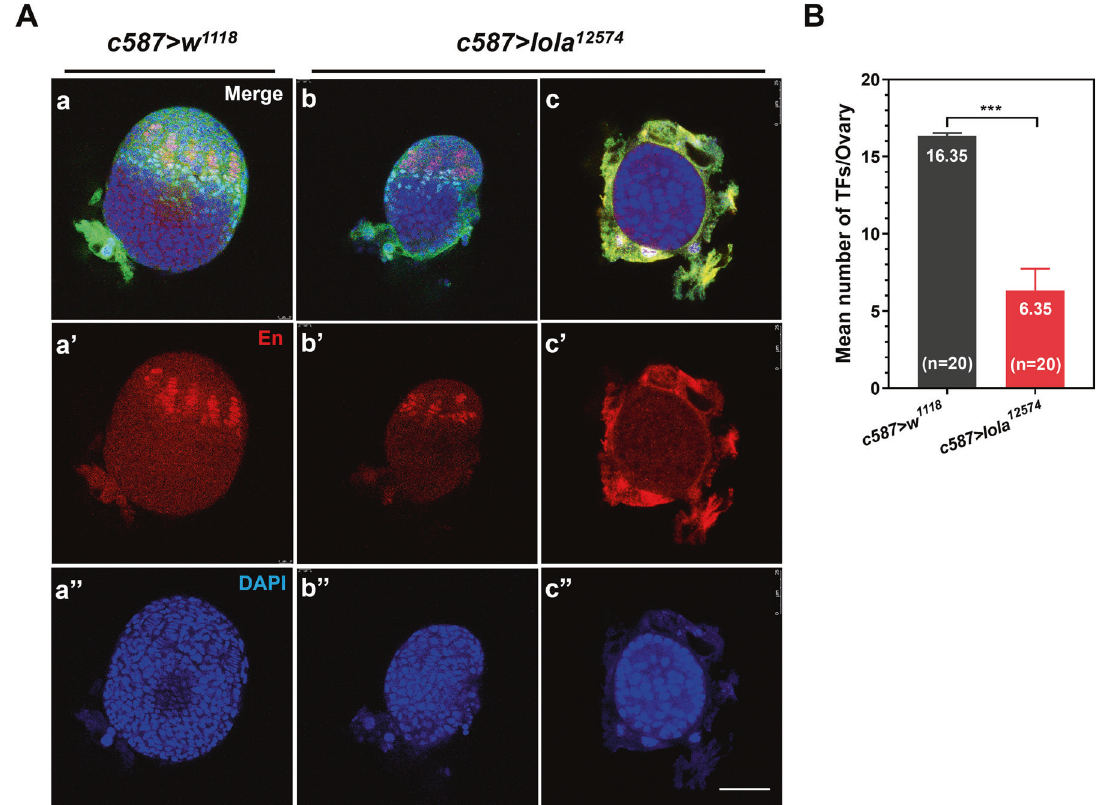
Fig. 4 RNAi of lola affects TF formation during WPP. A Ovaries from the control c587 > w 1118 line ( a) and c587 > lola 12574 RNAi line ( b , c ) at the WPP stage were immunostained with En antibody to mark TFCs ( a ’ -c ’ , red), and nuclei were stained with DAPI ( a ” – c ” , blue). In a control ovary ( a – a ” ), TFs were well organized, while in c587 > lola 12574 RNAi ovaries, either some TFCs were arranged randomly ( b – b ” ) or no TFs were formed ( c – c ” ). B The mean number of TFs per ovary in c587 > lola 12574 RNAi ovaries is signi fi cantly lower than that of the c587 > w 1118 control ovaries ( n = 20). Signi fi cant difference was determined by the student ’ s t-test and indicated by *** p < 0.001. Scale bar: 30